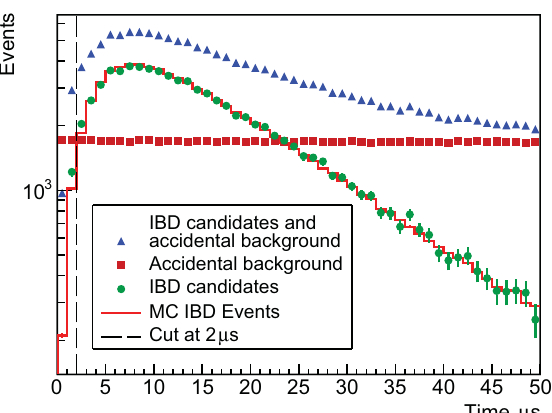
Figure 6. Time between prompt and delayed signals. Errors are smaller than sizes of points.The histogram is the MC prediction for the IBD